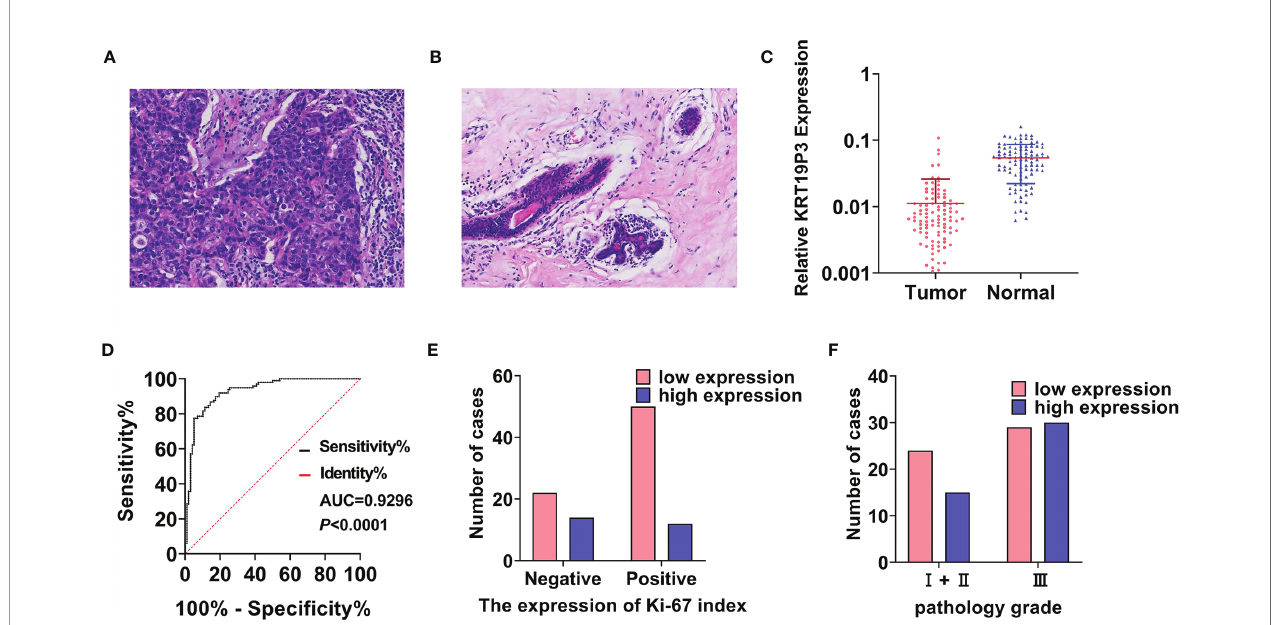
FIGURE 3 | LncRNA KRT19P3 signi fi cantly decreased in human BC tissues. (A) HE pictures of breast cancer tissue (H&E × 200). (B) HE pictures of normal breast tissue (H&E × 200). (C) The expression of KRT19P3 in human breast cancer tissues (Tumor, n=98) and corresponding para cancer tissues (Normal, n=98) was detected by RT-qPCR. (D) The ROC curve was drawn according to the expression of KRT19P3 in breast cancer tissues and para cancer tissues (AUC=0.9296, P <0.0001). (E) Relationship between KRT19P3 and Ki-67 index (Ki-67 positive rate ≥ 30%, r= -0.213, P <0.05). (F) Relationship between KRT19P3 and pathology grade (r= -0.227, P <0.05).